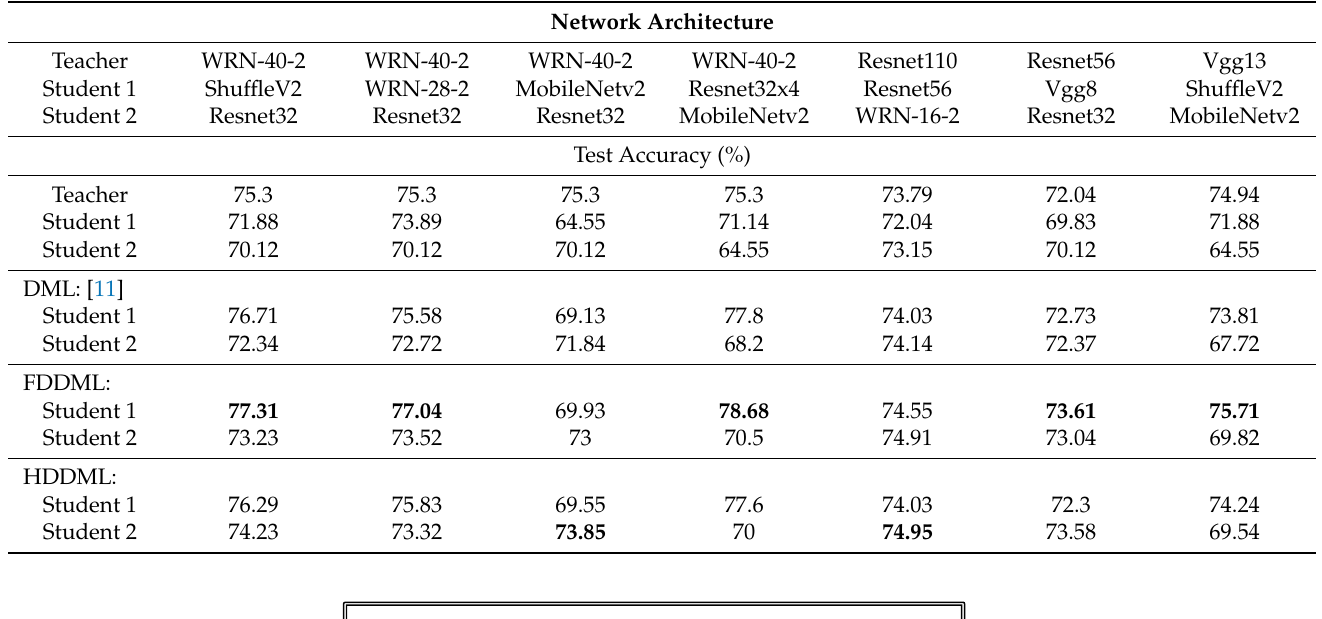
Table 3. Comparing resultstop-1 accuracy on the CIFAR-100 datasets with different student network. Network Architecture